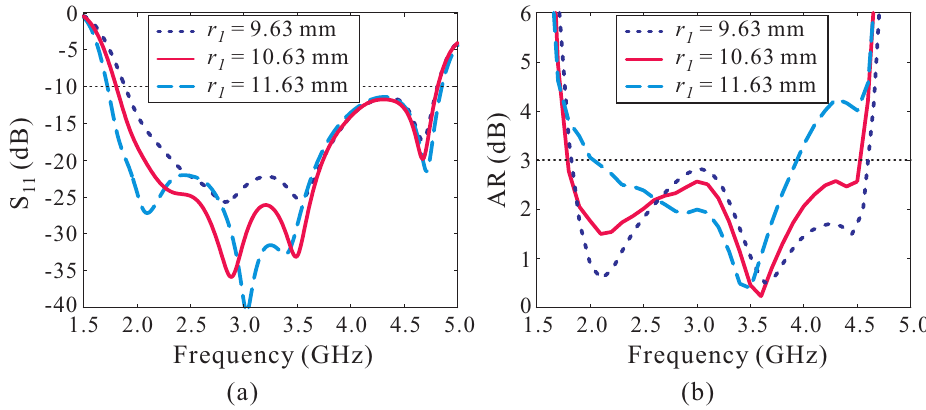
Figure 4. Effect of radius r 1 of circular patch loading O 1 on antenna performance: ( a ) reflection coefficients; ( b )